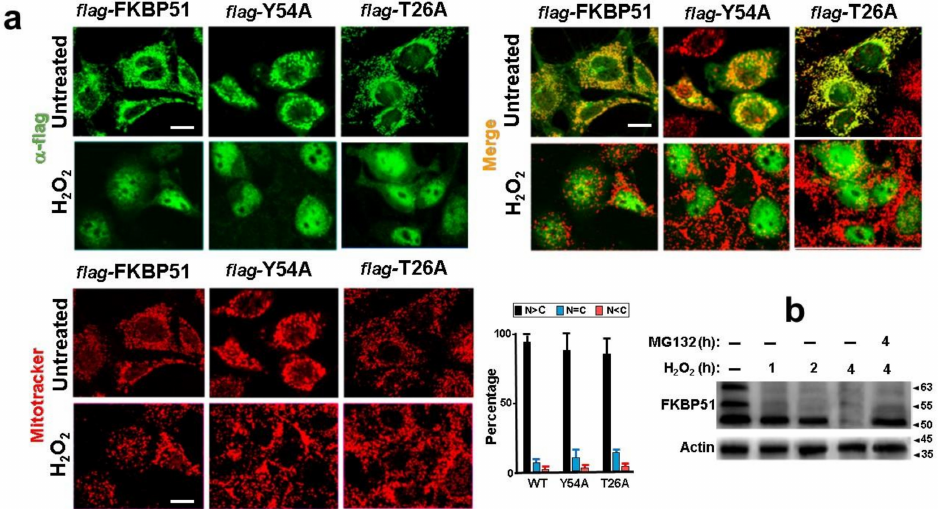
Figure 5. ( a ) The subcellular localization of FKBP51 is not affected by Tyr-54 and Thr-26 phosphoryla- tion. Confocal microscopy of transfected N2a cells with flag -tagged FKBP51 mutants and flag -tagged FKBP51 wild type. Basal and the peroxide-dependent nuclear localization of both FKBP51 mutants and wild-type immunophilin are alike (green). Mitochondria were stained with Mitotracker (red). Bar = 10 um. The bar graph shows no significant differences for the subcellular distribution of the mutants. ( b ) Peroxide treatment targets FKBP51 to proteasome degradation. N2a cells were treated with 0.25 mM H 2 O 2 for 1 h, 2 h, or 4 h, and FKBP51 was Western blotted with the commercial rabbit polyclonal IgG. Endogenous FKBP51 is dephosphorylated and degraded after 4 h, presumable due to proteasome degradation since degradation is prevented with 10 µ M